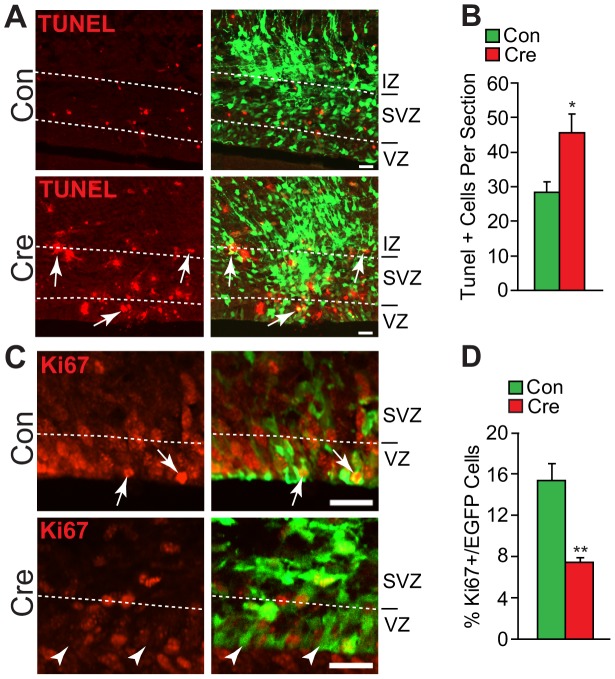
Snail controls cell survival and proliferation of cortical precursors in the embryonic cortex.Cortices of Snailfl/fl mice were electroporated at E13/14 with an expression construct that encodes both Cre recombinase and EGFP (Cre), and were analyzed three days later. As a control, cortices were electroporated with the same construct that encodes EGFP alone (Con). (A) Confocal micrographs of coronal cortical sections immunostained for EGFP (green) and labeled for TUNEL (red). The left panels show TUNEL alone, and the right the merges. The hatched white lines denote the different cortical regions. Arrows denote the double-labeled cells. Scale bar 20 µm. (B) Quantification of sections as in A for total TUNEL positive cells per section. (*p<0.05; n = 4 brains each). (C) Confocal micrographs of coronal cortical sections immunostained for EGFP (green) and Ki67 (red). The left panels show Ki67 immunostaining alone and the right panels the merges. The hatched white lines indicate the border between the VZ and SVZ. Arrows denote double-labeled cells and arrowheads EGFP-positive cells that are Ki67-negative. Scale bar 20 µm. (D) Quantification of sections as in C for the relative proportion of EGFP-positive cells that are also positive for Ki67. (**p<0.01; n = 4 brains each).